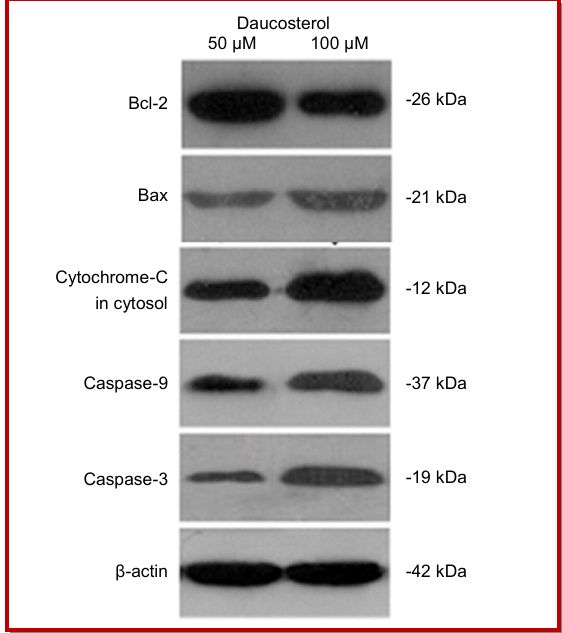
Figure 7: Western blot analysis of the various proteins associ- ated with the apoptotic